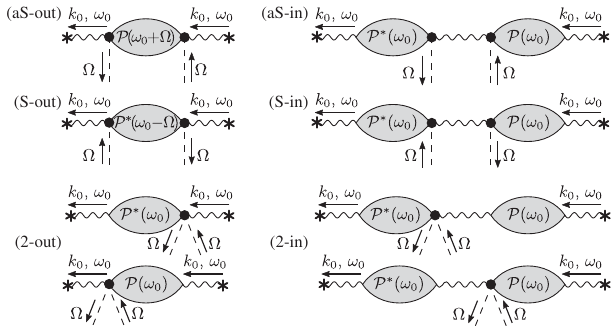
FIG. 10. Diagrammatic representation for the optomechanical correction to the mechanical motion self-energy. Star stands for the optical pump. In the four upper diagrams, the solid dot denotes the first-order optomechanical interaction, Eq. (B3). In the four lower diagrams, the solid dot represents the second-order optomechanical interaction described by Λ ð 2 Þ ¼ − j u j 2 k 2 , where k is the wave vector of the involved photon, and u is the